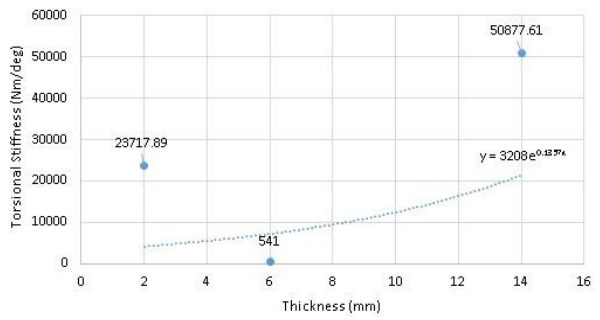
Figure 10: Effect of chassis thickness on torsional